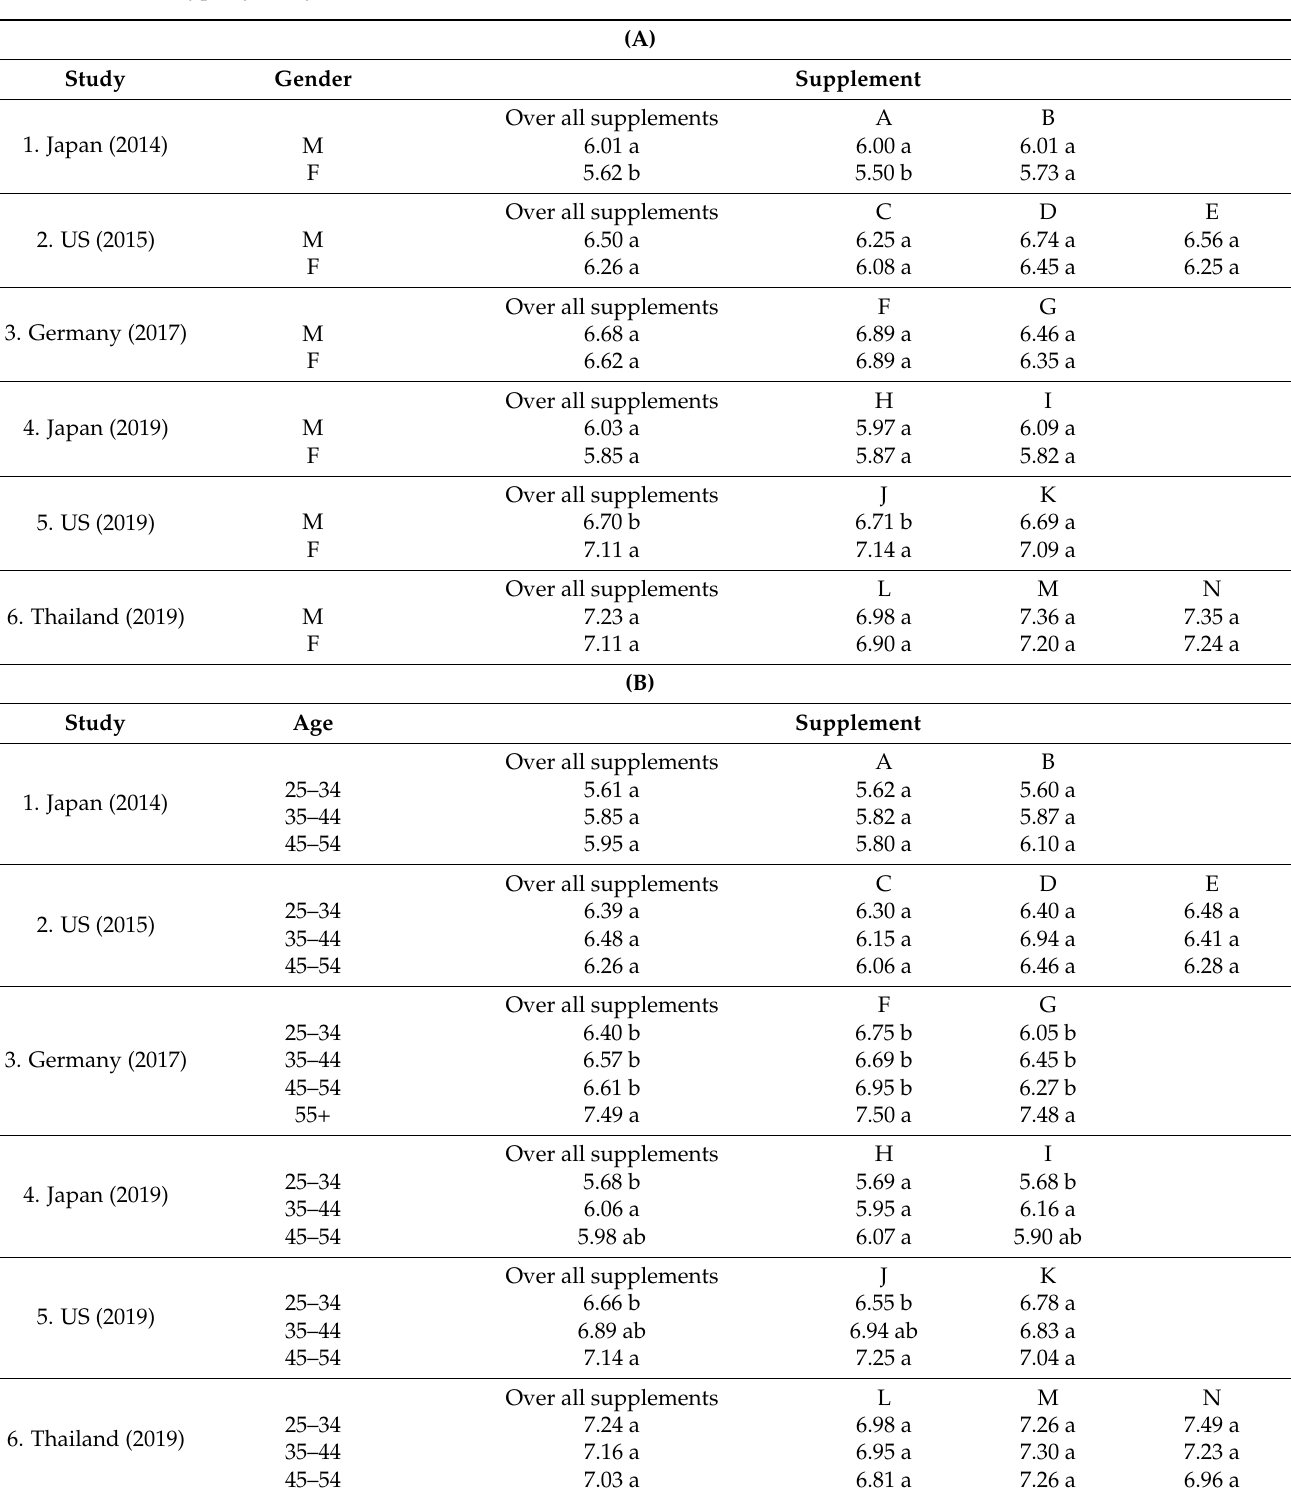
Table 3. ( A ). Studies 1–6: overall liking mean ratings—demographic effects of gender by study. ( B ). Studies 1–6: overall liking mean ratings—demographic effects of age group by study. ( C ). Studies 1–6: overall liking mean ratings—demographic effects of user type by